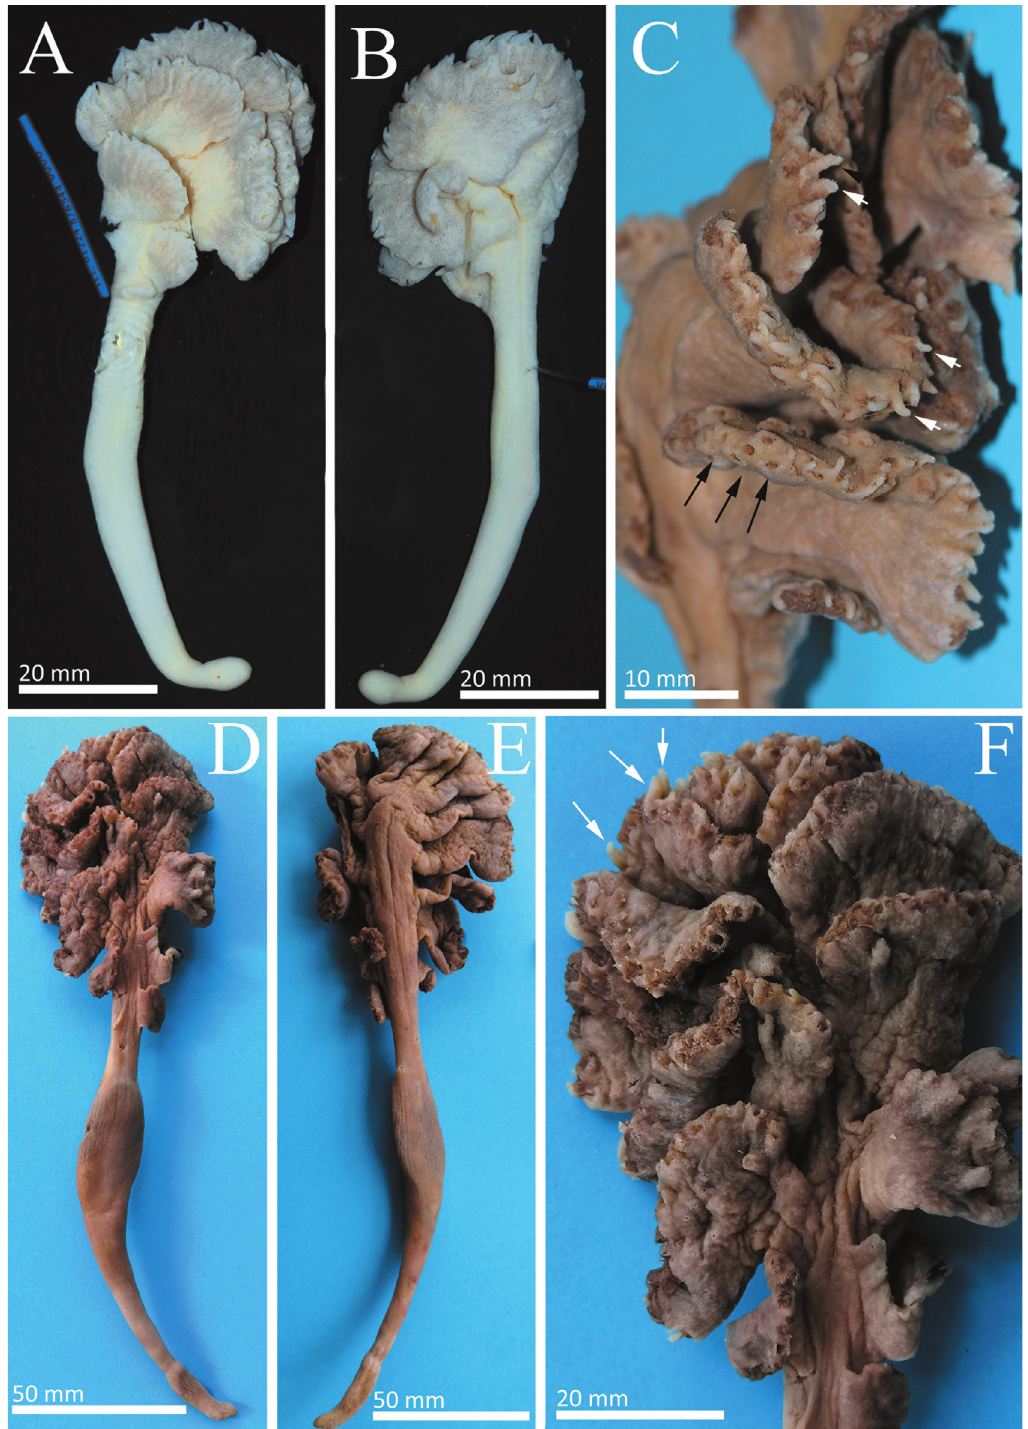
Fig. 3. Gyrophyllum hirondellei Studer, 1891, colonies from SCOTIA cruises. A–B . BECA (OPEN- 660), ventral and dorsal sides, see also Fig. 4. C . Detail from colony NMS.Z.2022.1.6, showing parts of polyp leaves ventral edge with well-developed BPPs (white arrows) and others without BPPs (black arrows). D–E . Ventral and dorsal sides of the colony NMS.Z.2022.1.4. F . Detail from D, showing most of the proximal polyp leaves without BPPs, some can be seen on the distalmost polyp leaves (white